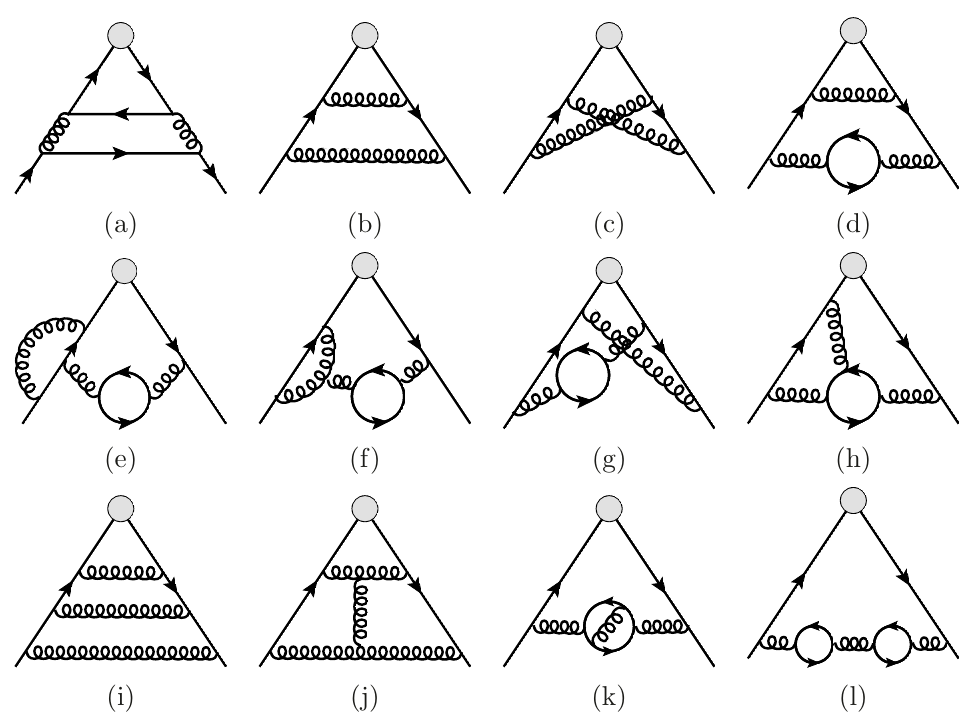
Figure 1 . Sample diagrams contributing to the form factors. Solid and curly lines represent quarks and gluons, respectively. The grey blob refers to one of the external currents given in eq. (1.1). Singlet contributions, as shown in (a), are not considered in this